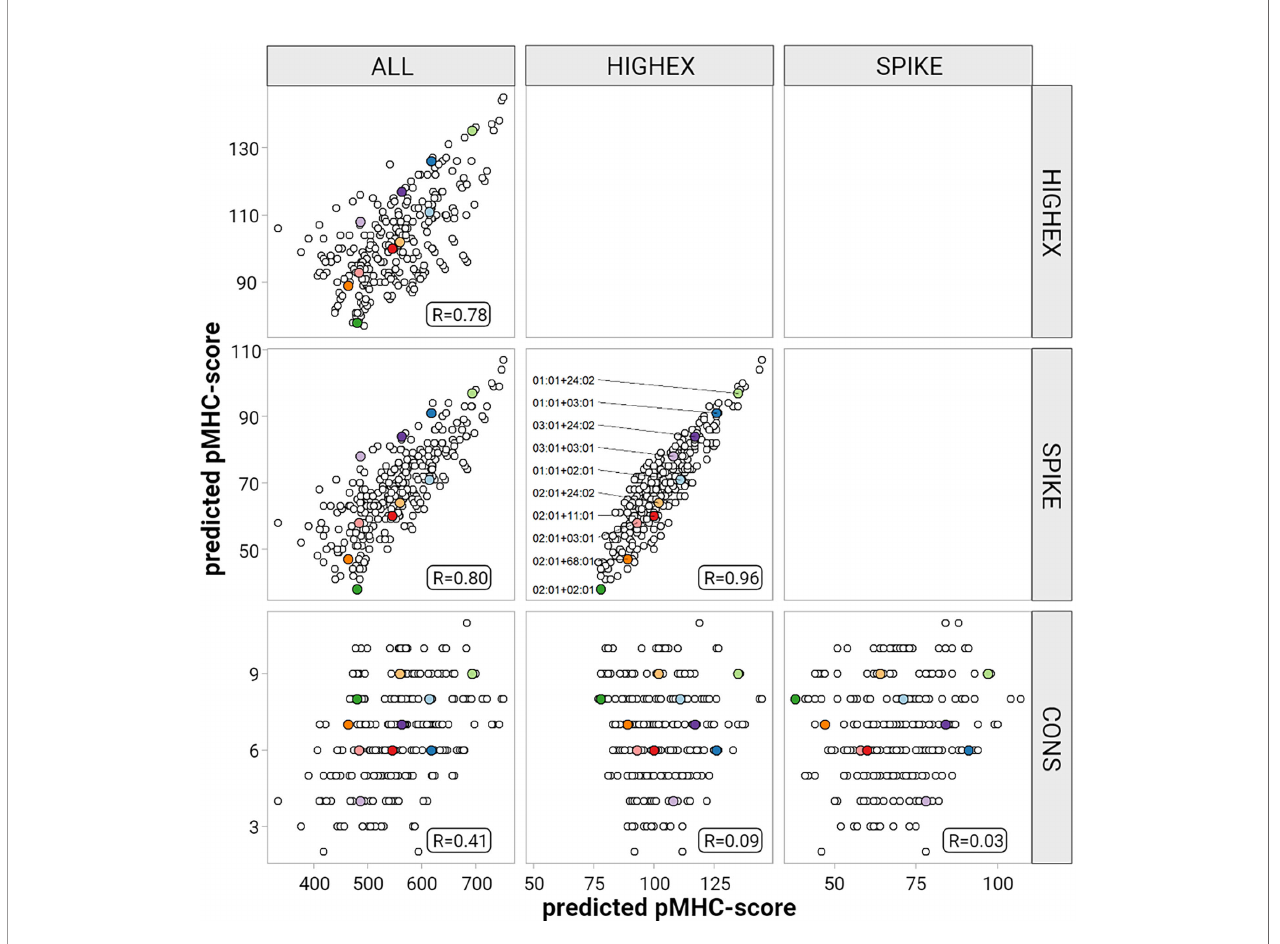
FIGURE 5 | Correlation of the predicted pMHC-score for different peptide pools. This fi gure displays results for HLA-A pair-wise comparisons of the predicted pMHC-scores derived from the different peptide pools (entire peptidome (ALL), highly expressed proteins (HIGHEX), spike glycoprotein (SPIKE) and conserved regions (CONS)) for each patient. Pair-wise Pearson ’ s correlation coef fi cients are given in each panel. The ten most common HLA-A allele diplotypes are highlighted as colored